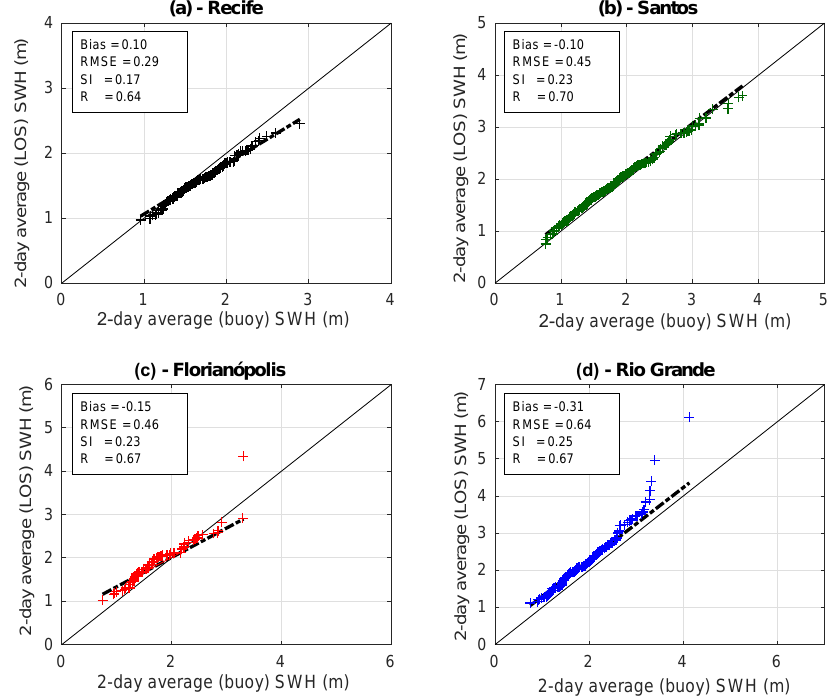
Figure 4. Comparison of quantile–quantile plots between 2-day averaged buoy data for stations in Recife (a) , Santos (b) , Florianópolis (c) , Rio Grande (d) and the nearest LOS interpolated time